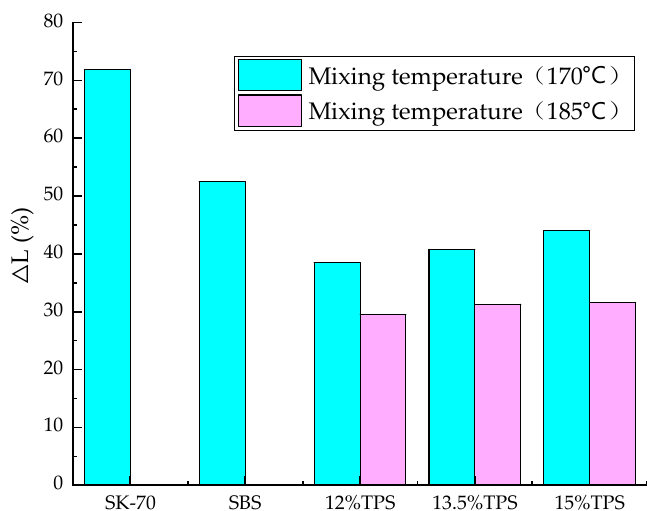
Figure 6. Test results from the boiling–sieving method with different asphalts.